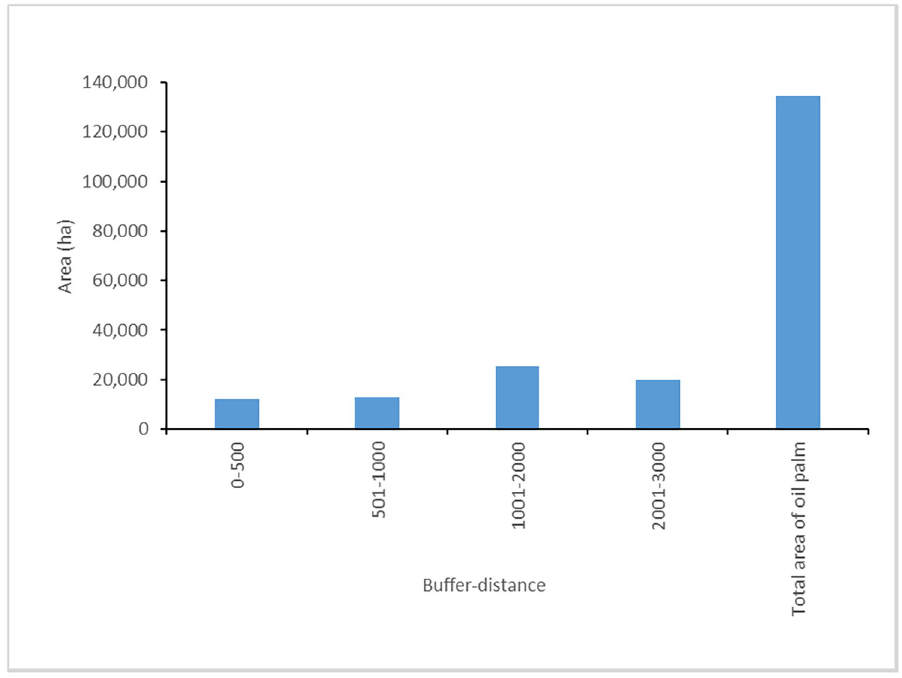
Fig 6. Total Oil palm areas (in hectares) estimated at a distance of 500, 1000, 2000 and 3000 m.